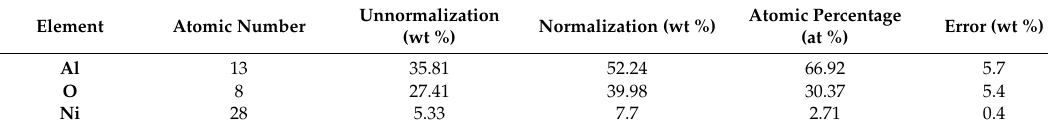
Table 2. EDS pattern of as-prepared grain-like Ni / Al 2 O 3 / Ni film. 65-2865. The 40.22°, 46.38°, 67.49° diffraction peak was related to the γ -Al 2 O 3 basement, because the Unnormalization Element Atomic Number (wt %)